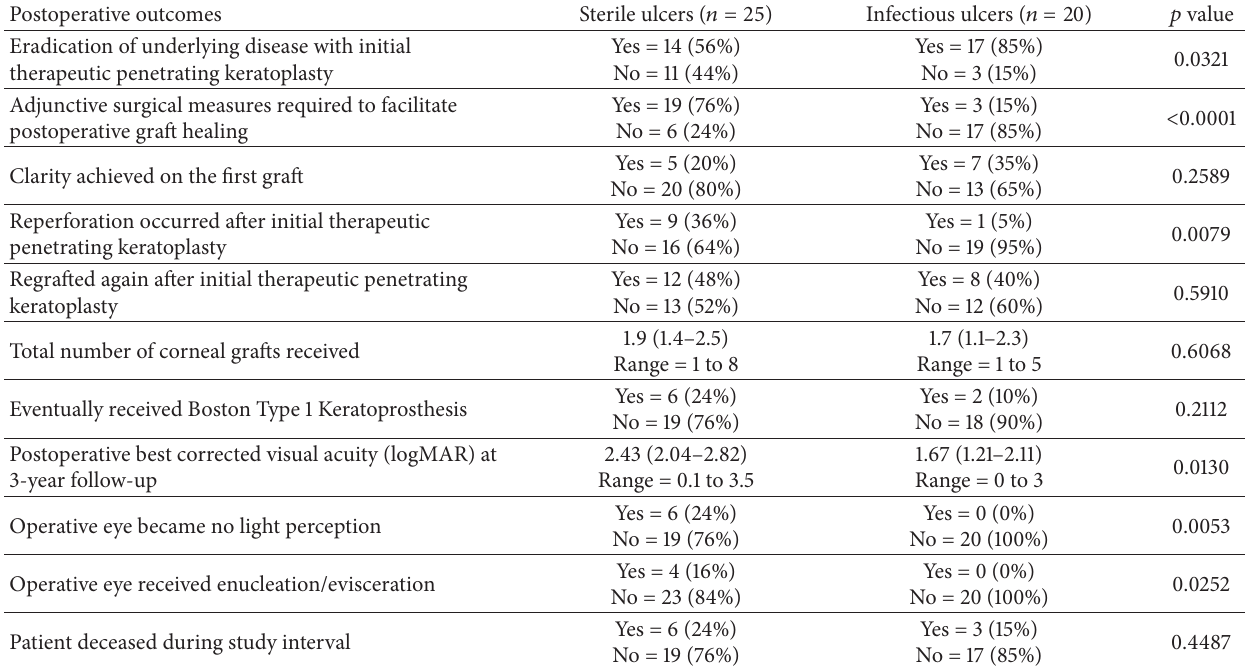
Table 3: Comparison of postoperative outcomes of sterile versus infectious perforated corneal ulcers that required therapeutic penetrating keratoplasty (with 95% confidence